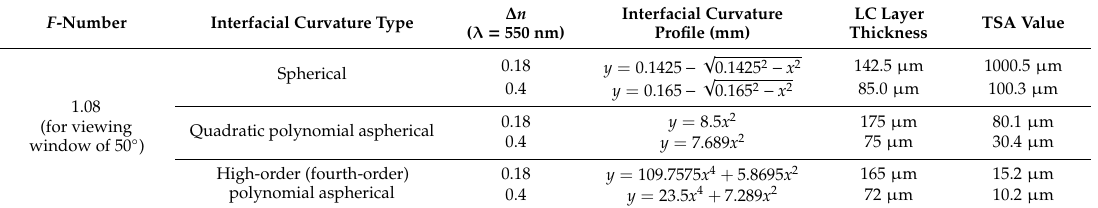
Figure 3. Simulation results for ray distributions for the low- ∆ n LC GRIN lens array with different interfacial curvatures: ( a ) spherical, ( b ) quadratic polynomial aspherical, and ( c ) high-order (fourth-order) polynomial aspherical curvatures. Table 1. Design parameters of LC GRIN lens arrays and TSA